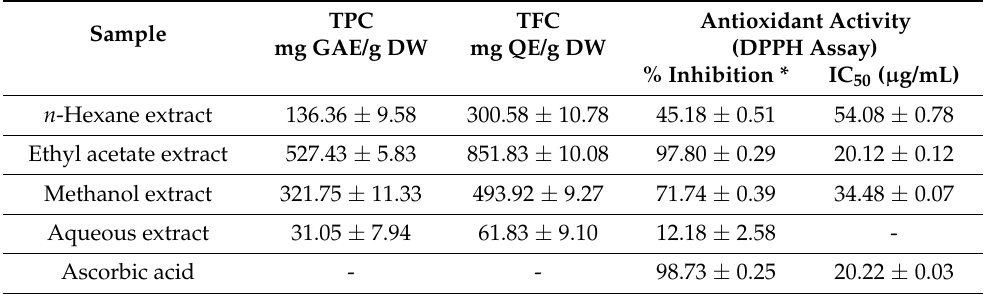
Table 2. Total phenolic content, total flavonoid content, and antioxidant activity of Cassia timoriensis flower